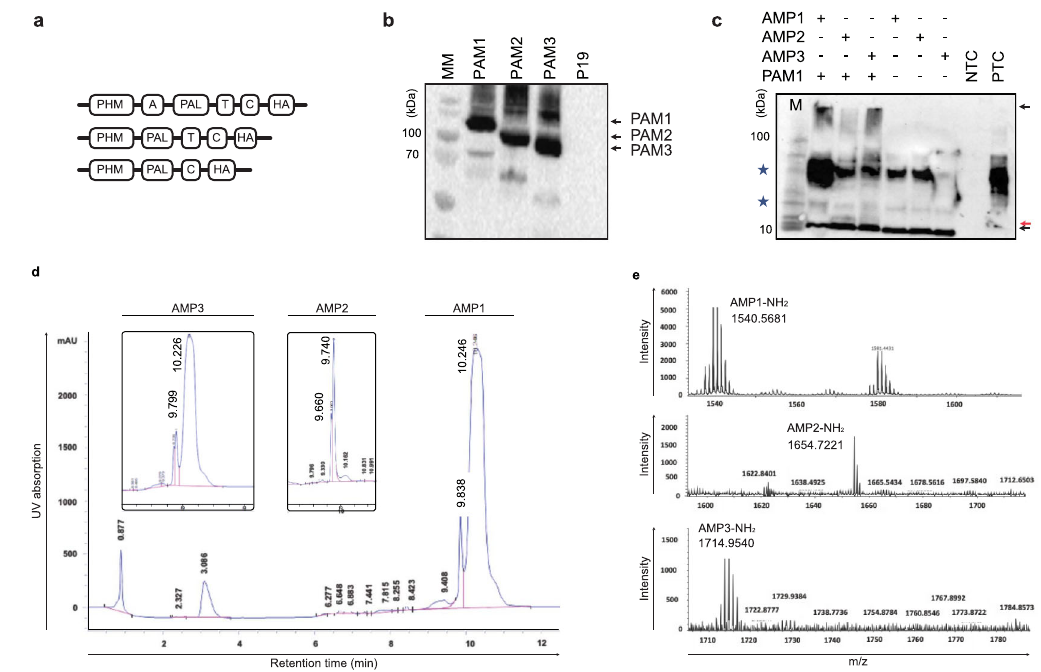
Fig. 2 | Plant-based platform for production of amidated AMPs. a Schematic diagram of chimeric cassettes with different variants of bifunctional rat PAMs and the different domains: PHM, peptidylglycine α -hydroxylating monooxygenase domain; PAL, peptidyl- α -hydroxyglycine α -amidating lyase domain; A, region encoded by exon 16 separating the PHM and PHL domains; T, transmembrane domain; C, cytoplasmic domain. The HA epitope was added for immunodetection of PAMs. b In planta transient expression of PAM enzymes. Each plasmid was individually co-in fi ltrated in N. benthamiana leaves along with a plasmid encoding P19. Leaves were harvested 3 dpi, total proteins were extracted and analyzed by immunoblotting using a monoclonal anti-HA antibody. The predicted molecular masses were 120kDa (PAM1), 105kDa (PAM2) and 95kDa (PAM3). The three black arrowheadsindicatethebandscorrespondingtoPAM1,PAM2,andPAM3enzymes. Two independent blots were performed with similar results. c In planta transient co-expression of AMPs and PAM enzymes. Constructs encoding AMPs and PAMs were transiently co-expressed in N. benthamiana (1:1 ratio) and the extracts were immunoblotted using anti-HA antibody. Black arrowheads indicate the expected